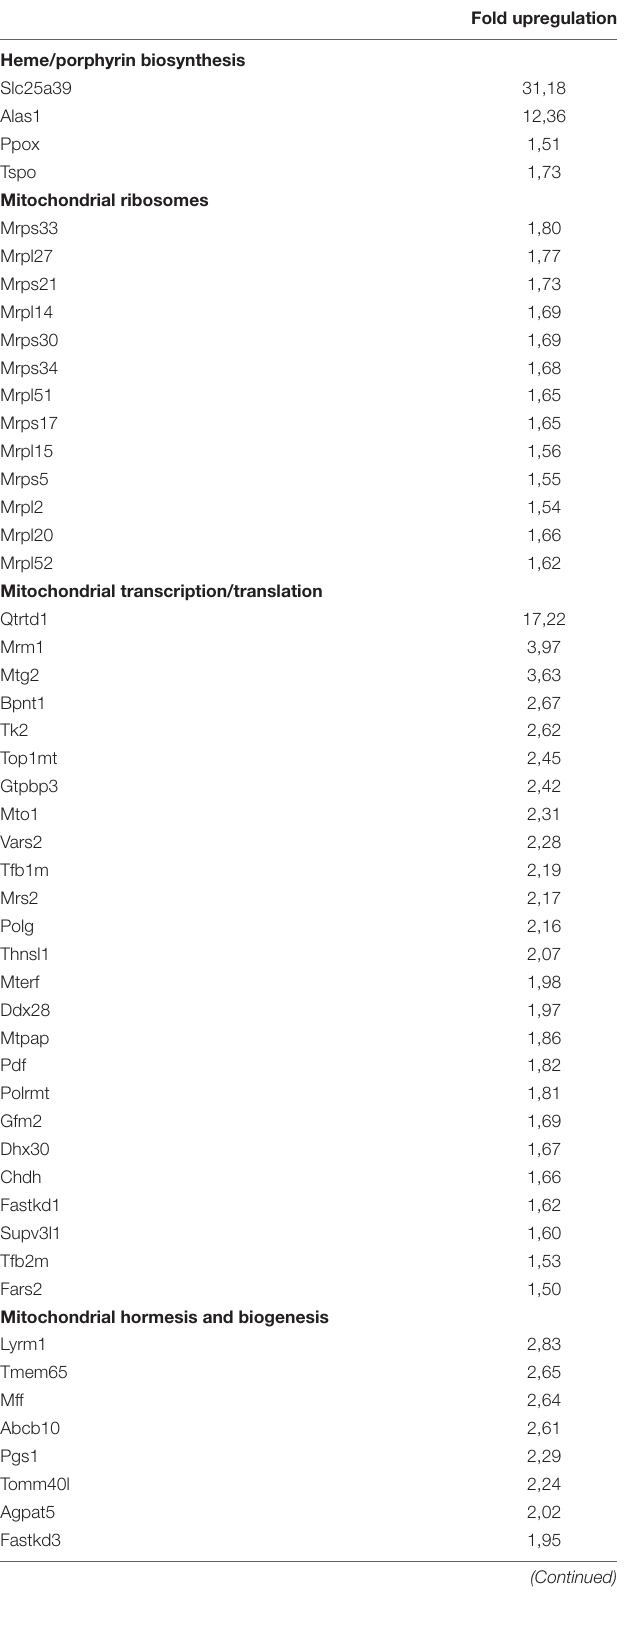
TABLE 1 | Grouped list of mitochondrial proteins upregulated by MB-6 treatment.